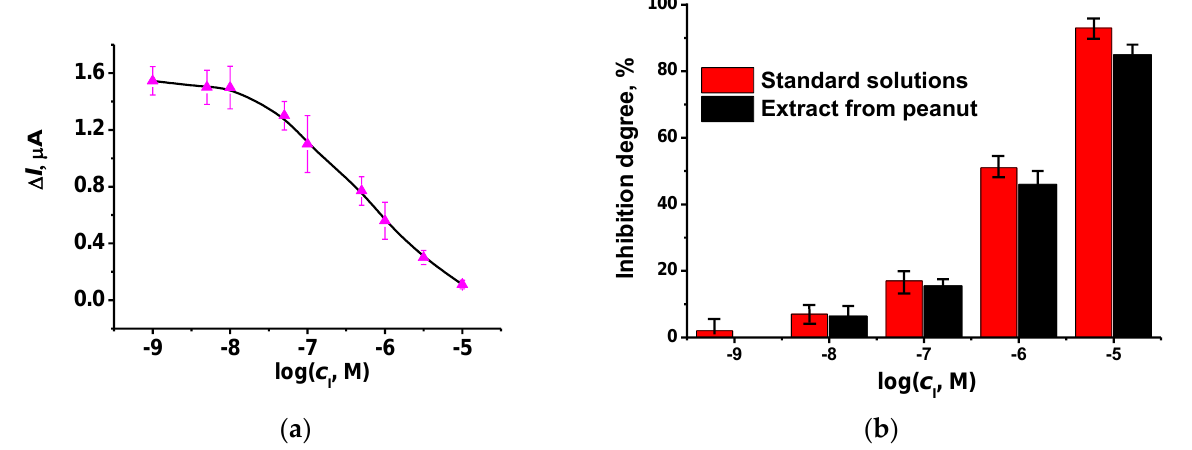
Figure 9. ( a ) Calibration curve of carbofuran obtained with the flow-through AChE biosensor. ( b ) Comparison of the inhibition degree recorded with standard solutions of carbofuran and diluted extracts from spiked peanut samples. Incubation 10 min., AChE 5 U per biosensor, ATCh 1.0 mM, flow rate 0.2 mL/min, phosphate buffer, pH = 7.0. Average ± standard deviation for six measure- ments.